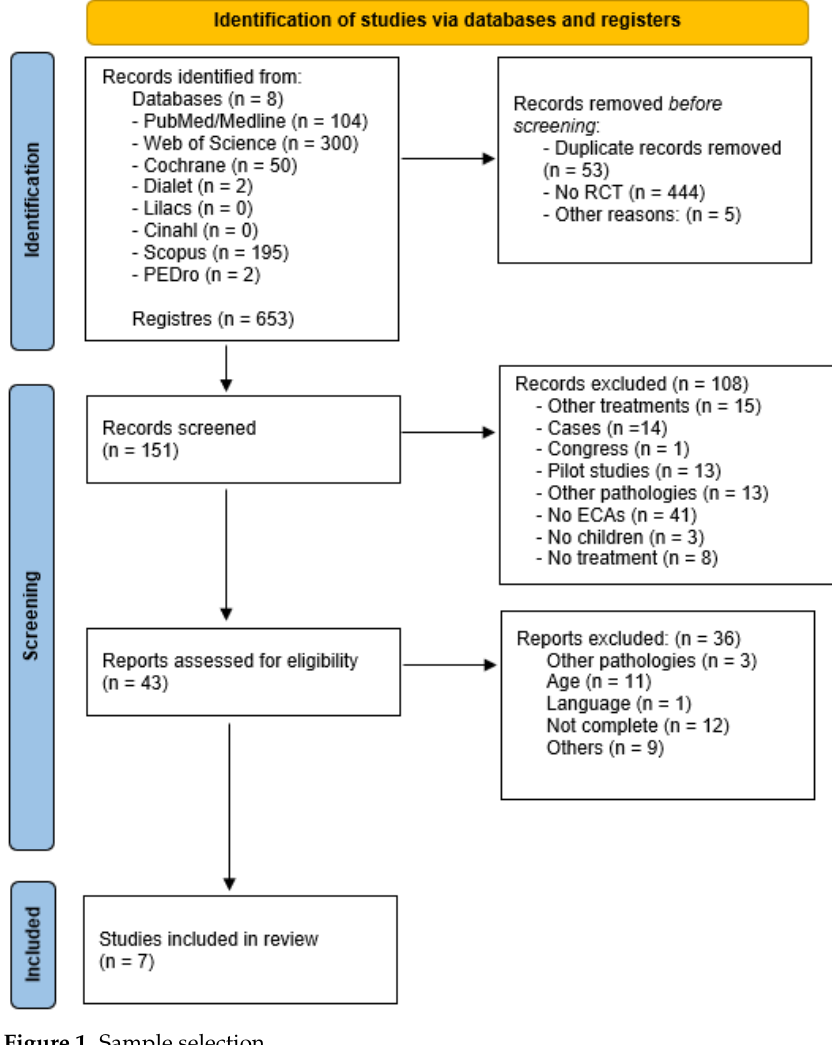
Figure 1. Sample selection. Table 1. Characteristics of the selected